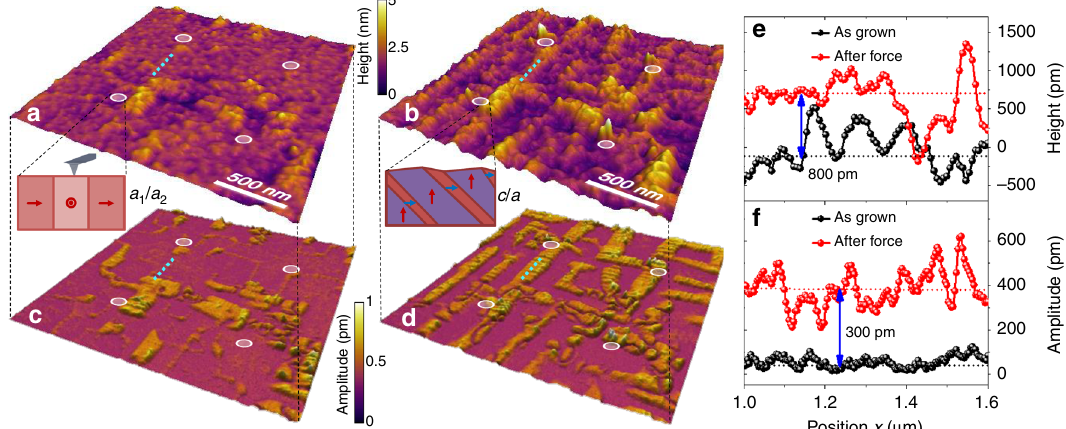
Fig. 3 Mechanical force-induced non-local, large-area ferroelastic switching. The force mapping is completed in a 2 × 2 array of points (the tip radius is ~25 nm) at the corners of a 1 × 1 µ m area within a 2 × 2 µ m scanned area. Topographic images of the fi lms a before and b after the application of local four- point force as noted by four shaded circles. Out-of-plane piezoresponse force microscopy (PFM) images in c as-grown state and d after the four-point force mapping. A dramatic change in the domain structure occurs outside the tip-sample contact area and appears in both the topography b and out-of-plane PFM amplitude d images after the application of ~600 nN force to the noted positions. Corresponding line pro fi le changes in e surface height and f out-of- plane PFM amplitude as indicated by the dashed lines in ( a – d ). The average height and out-of-plane PFM amplitude of the switched area are ~800 pm and ~300 pm higher than those of the as-grown a 1 / a 2 domains,